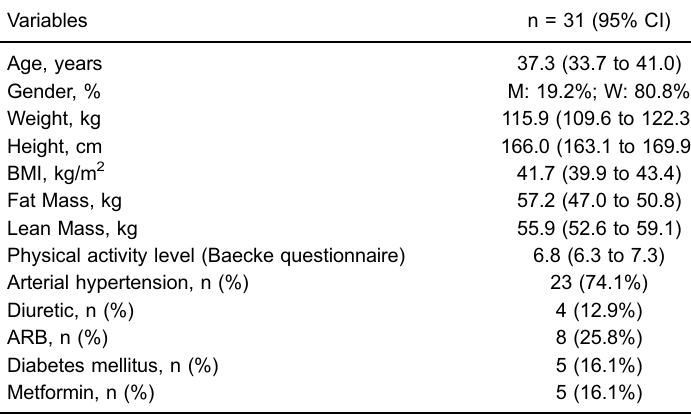
Table 1. General characteristics of the studied